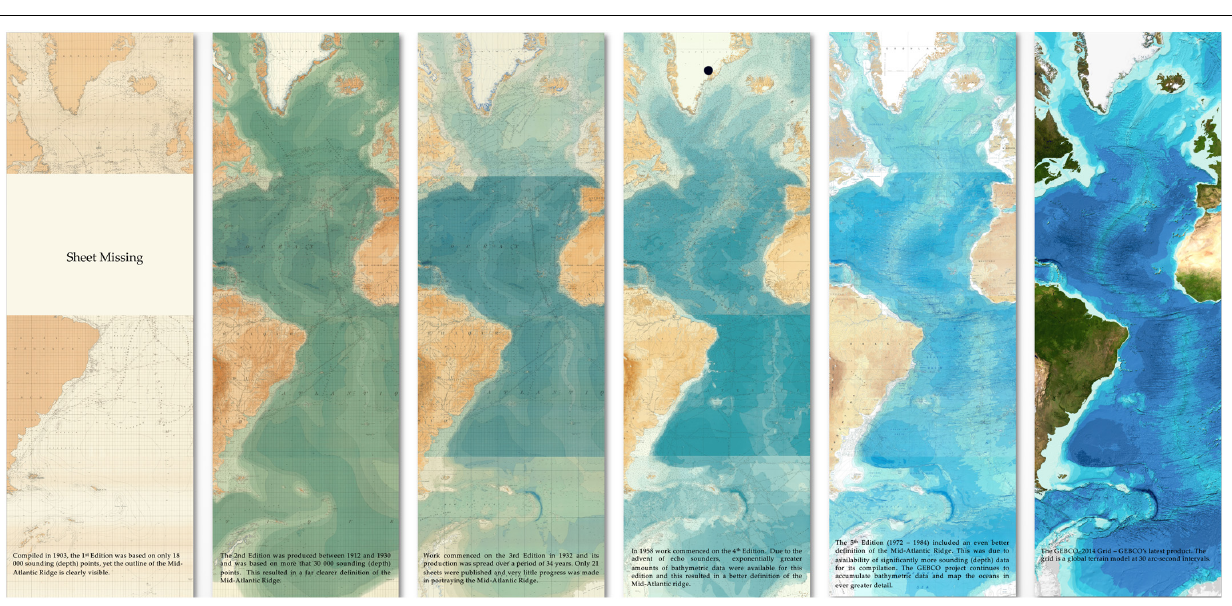
that contribute to Seabed 2030 and the GEBCO global map.